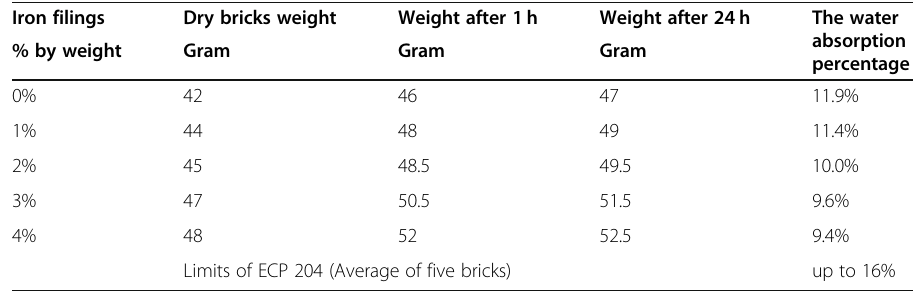
Table 3 Results of water absorption test Iron filings Dry bricks